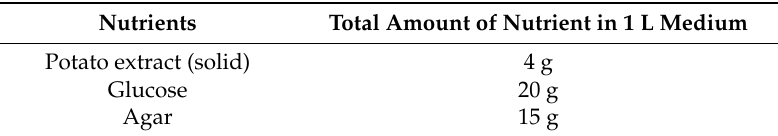
Table A8. Potato Dextrose agar (PDA, ApplChem, A5828, pH 5.6 (20 ◦ C).